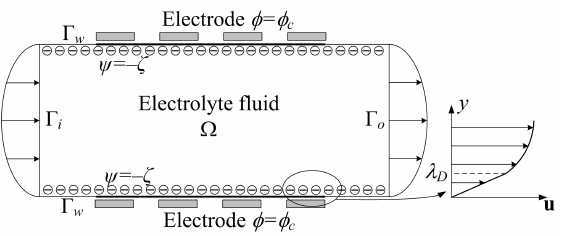
Figure 1. Schematic for the electroosmotic flow in the